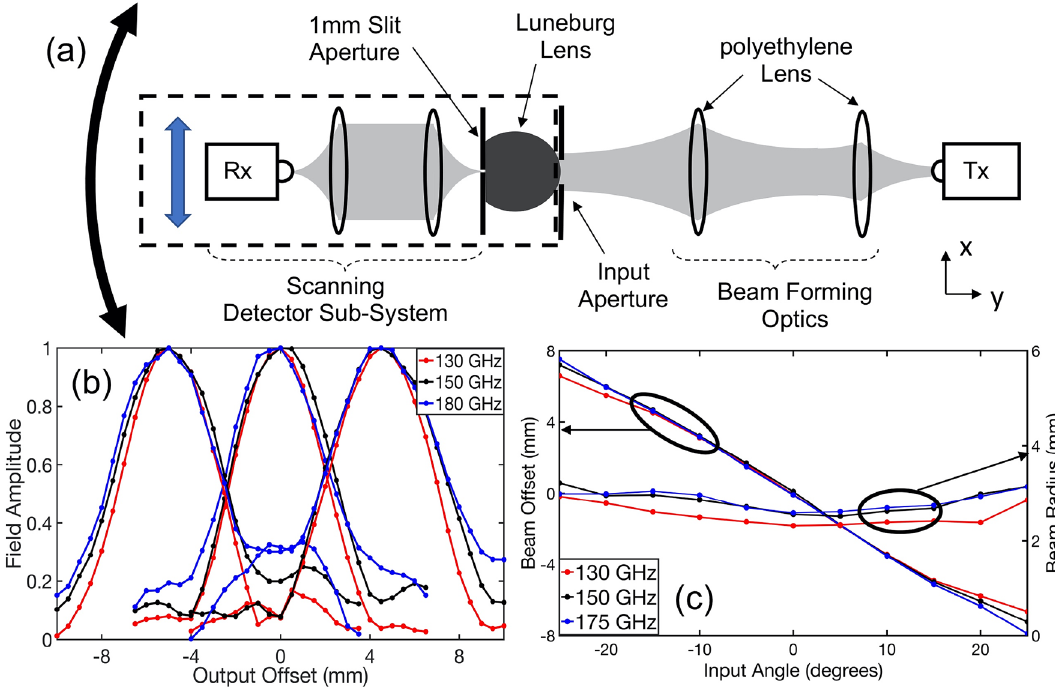
Figure 2. ( a ) Experimental setup for wide angle measurements. ( b ) Normalized electric field of the output beams at + 15 ◦ , 0 ◦ and − 15 ◦ for frequencies from 130 to 180 GHz. ( c ) Measured beam offset of the output beam and its radius as a function of the input beam